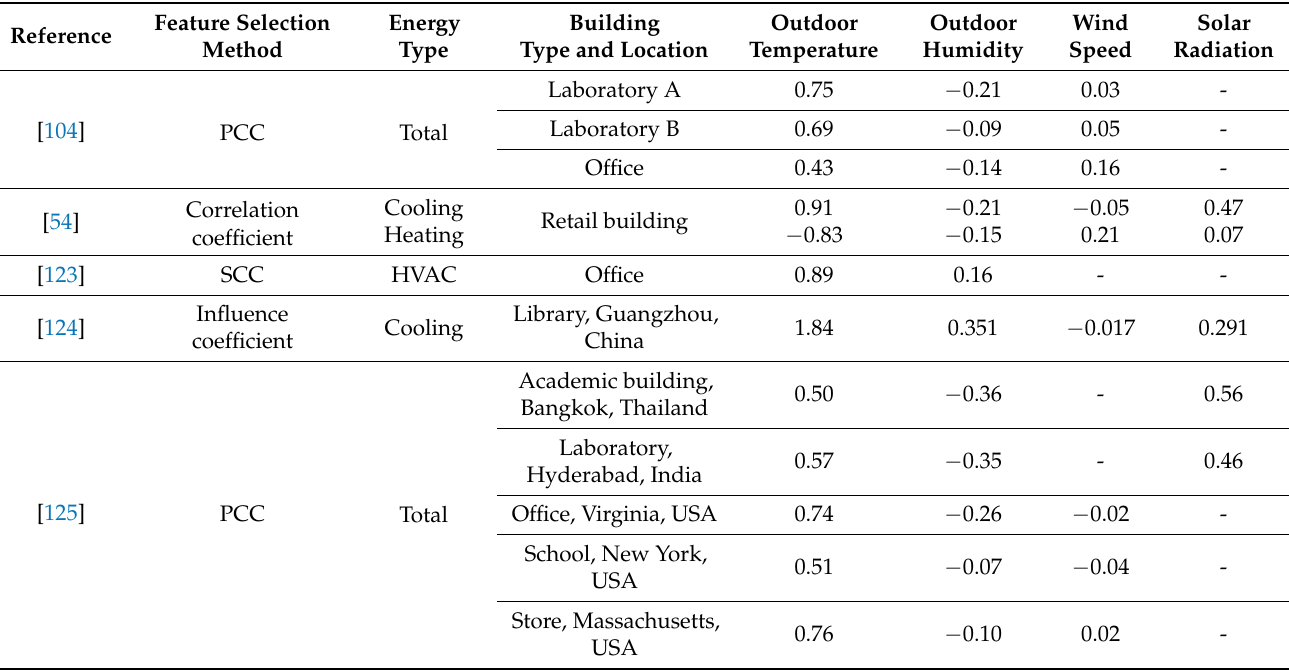
Table 4. Correlation between energy and meteorological